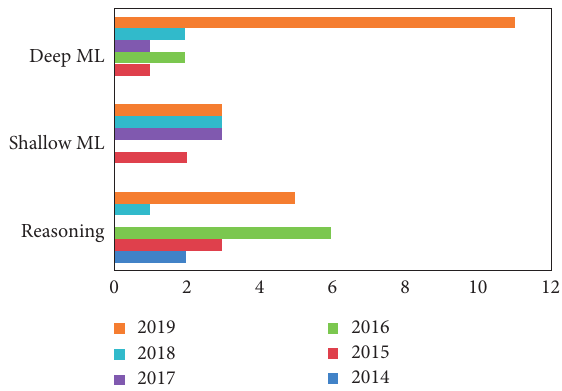
Figure 10: Application of AI models with